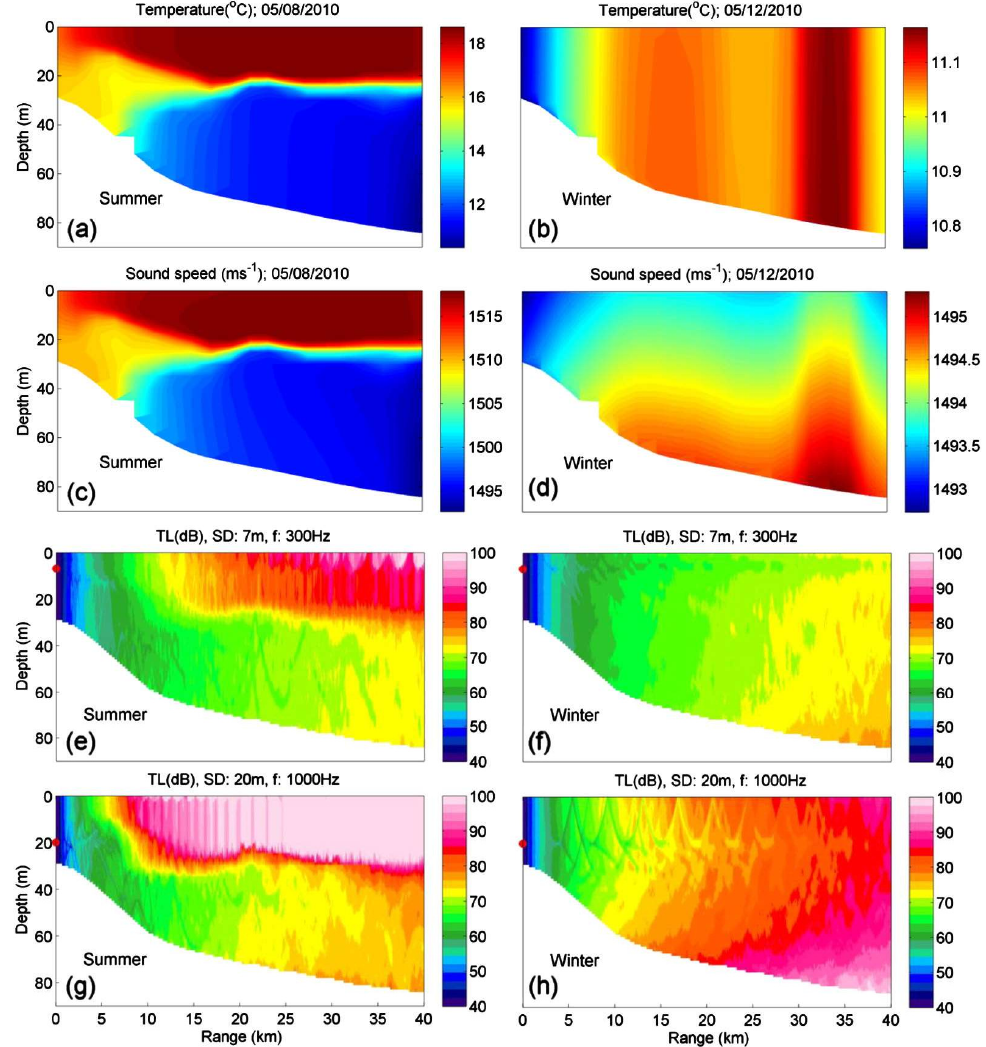
Figure 6. Seasonal variations of parameters when the sound source was on the onshore side of the ocean front in the Celtic Sea [73]: ( a , b ) temperature distribution; ( c , d ) sound speed distribution; ( e , f ) the TL at frequency 300 Hz with source depth 7 m; and ( g , h ) the TL at frequency 1000 Hz with source depth 20 m. The position of red dots represents the depth of the sound source.